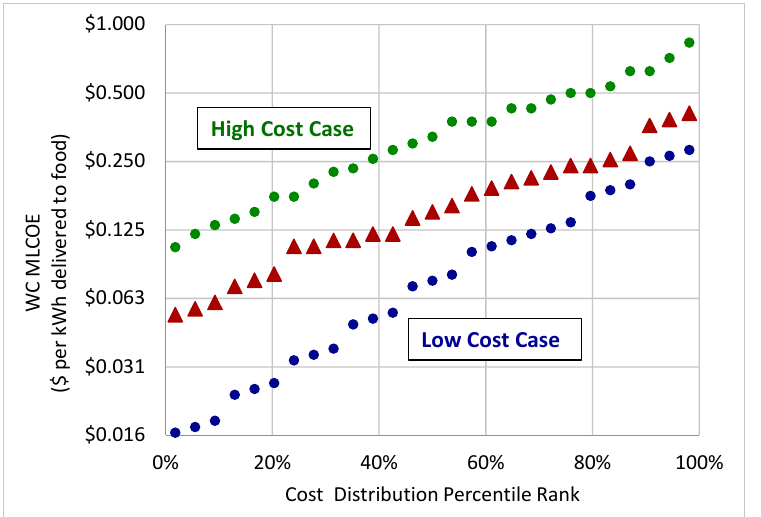
Figure 3. Three potential MLCOE distributions for the cost of wood cooking energy. For each case, WC MLCOE is calculated for all combinations of input parameters and then given a percentile rank relative to the set of all value combinations. Note that the vertical axis has logarithmic scaling.